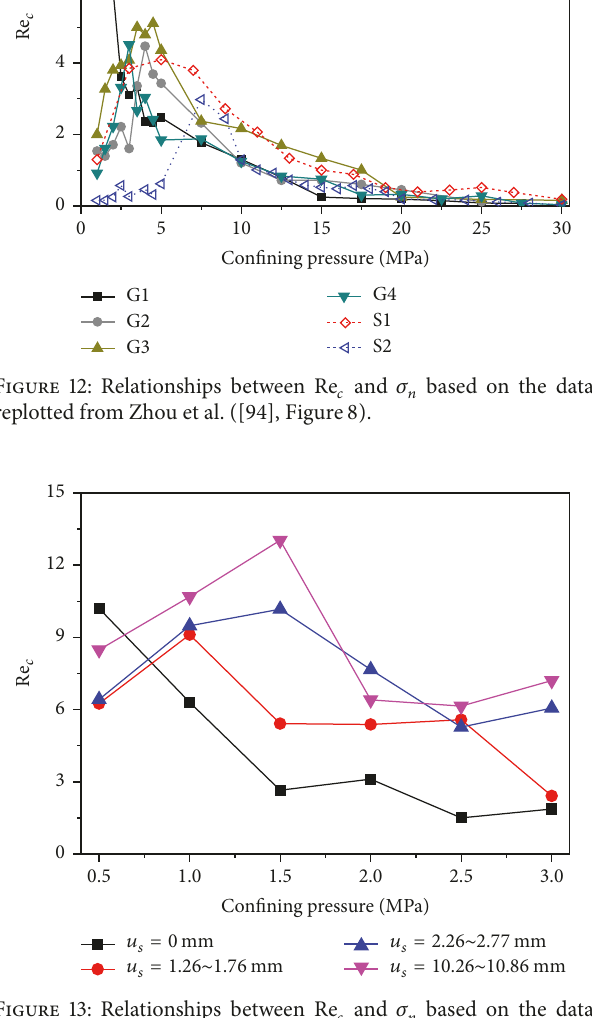
Figure 11: Relationships between depth and Re based on the data replotted from Chen et al. ([112], Tables 2 – 5 ).